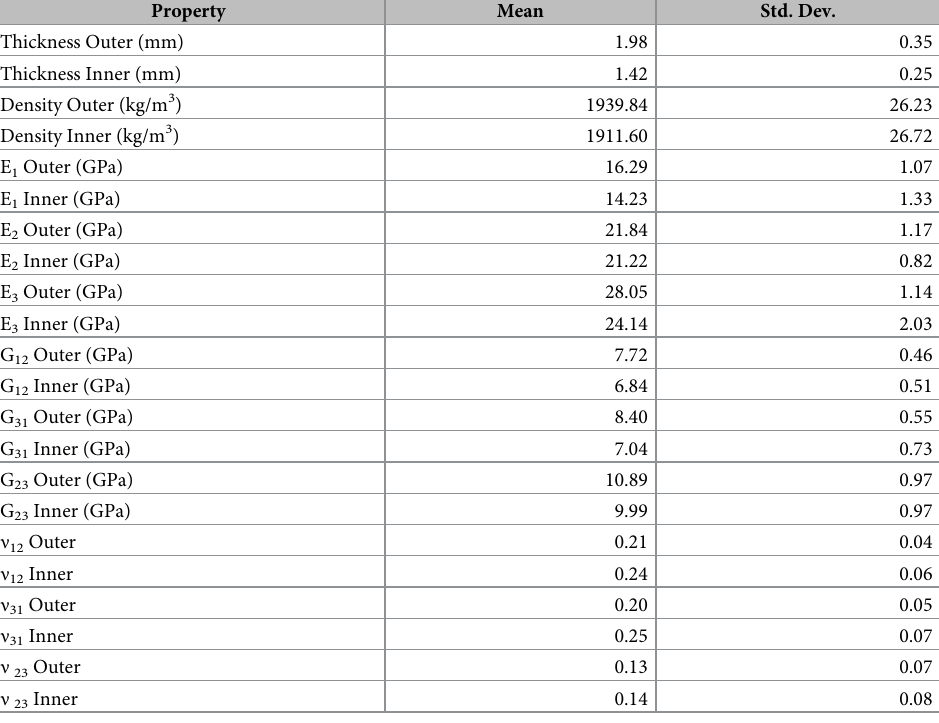
Table 1. Elastic mechanical properties for outer and inner cortical plates. Property Mean Std.